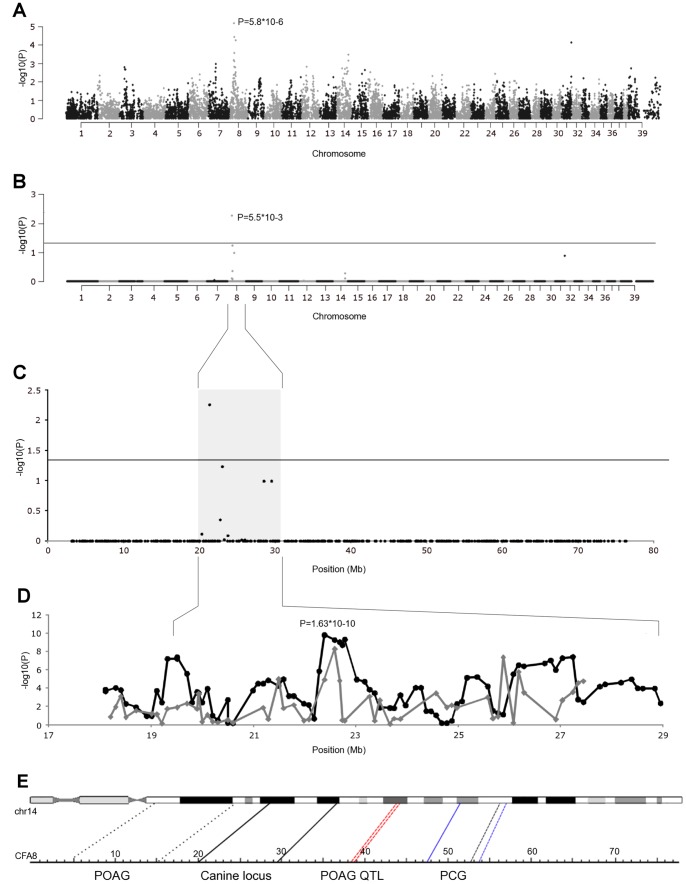
Genome wide association analysis.
A) A Manhattan plot of genome-wide case-control association analysis performed using 23 cases and 23 controls. B) Results of the genome-wide association analysis after 50,000 permutations. A significant association was identified on CFA8 (P = 5.83×10−6, Pgenome = 5.5×10−3). Horizontal line indicate the 5% significance level C) The glaucoma associated region on CFA8 spans from 20.0 Mb to 29.5 Mb. D) Results of the fine-mapping narrowed the best association to 22.0 and 23.6 Mb (P = 1.63×10−10). Gray line shows the individual SNP association, black line indicates the 5-SNP haplotype. E) The canine CFA8 locus (solid black line) maps to a human chromosome 14 to a 11 Mb region between 39.2 Mb to 50.4 Mb. Previously mapped GLC3C locus for PCG between 77.4 Mb to 78.6 Mb, maps to canine CFA8 at a region between 52.8 Mb to 53.9 Mb (dashed black line). Another PCG locus was mapped on chr14 between 71.5 Mb to 78.6 Mb which overlap the GLC3C locus (solid blue line). Two POAG loci were mapped on chr14 between 20.8–33.97 Mb (dotted black line) and a QTL locus between 60.79–61.0 Mb (dashed red line).